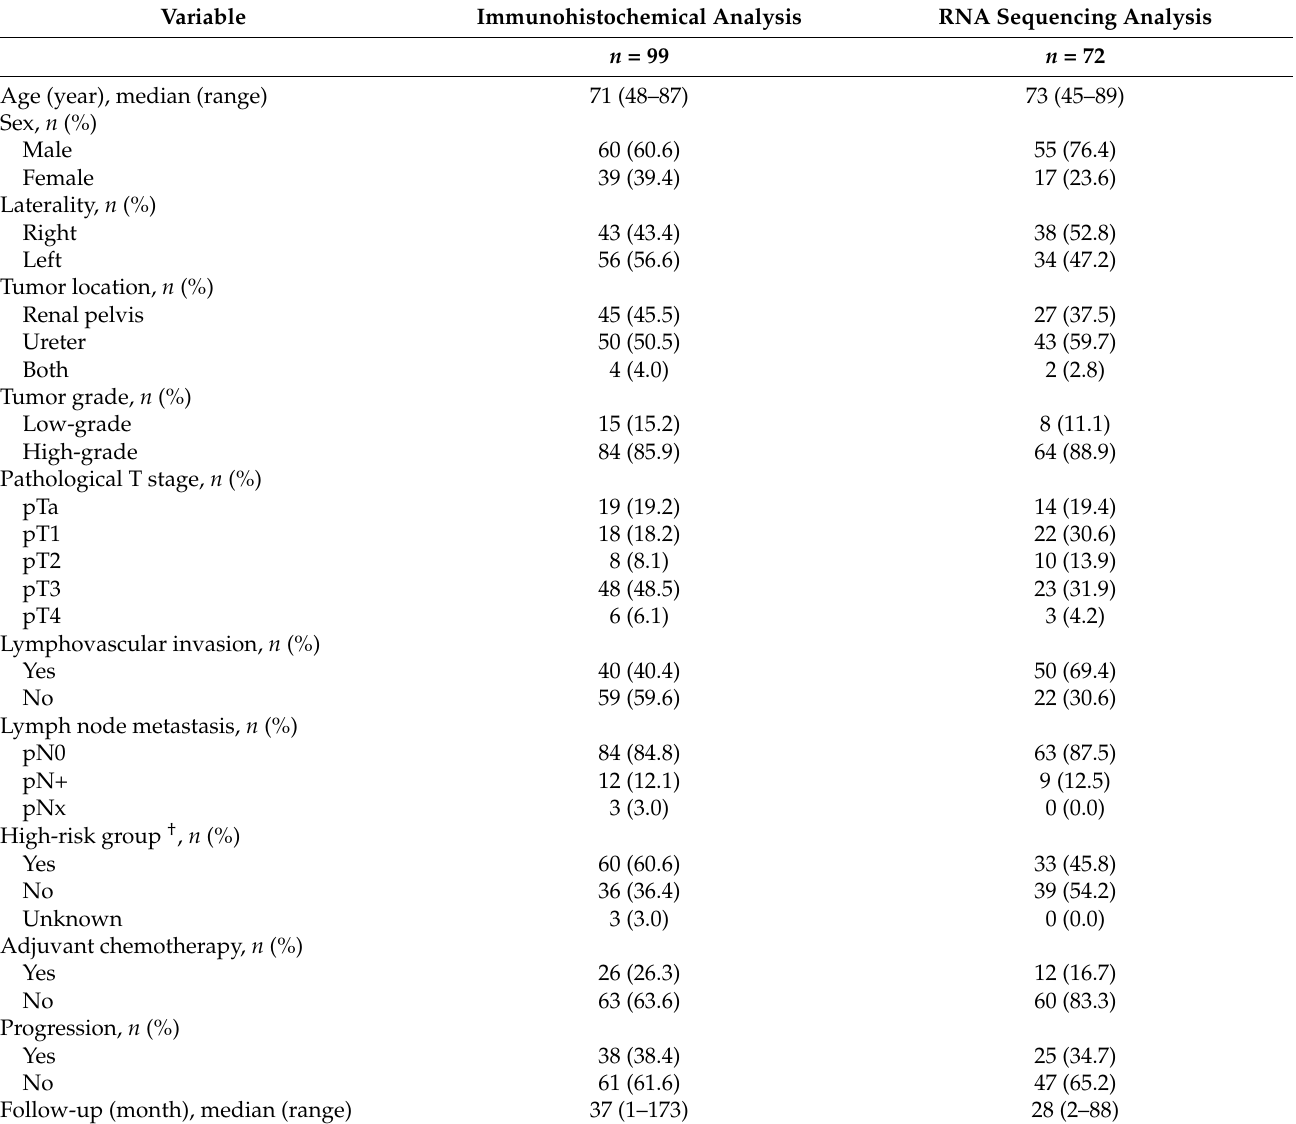
Table 1. Clinicopathologic characteristics and outcome of patients with upper tract urothelial carcinoma. Variable Immunohistochemical Analysis RNA Sequencing